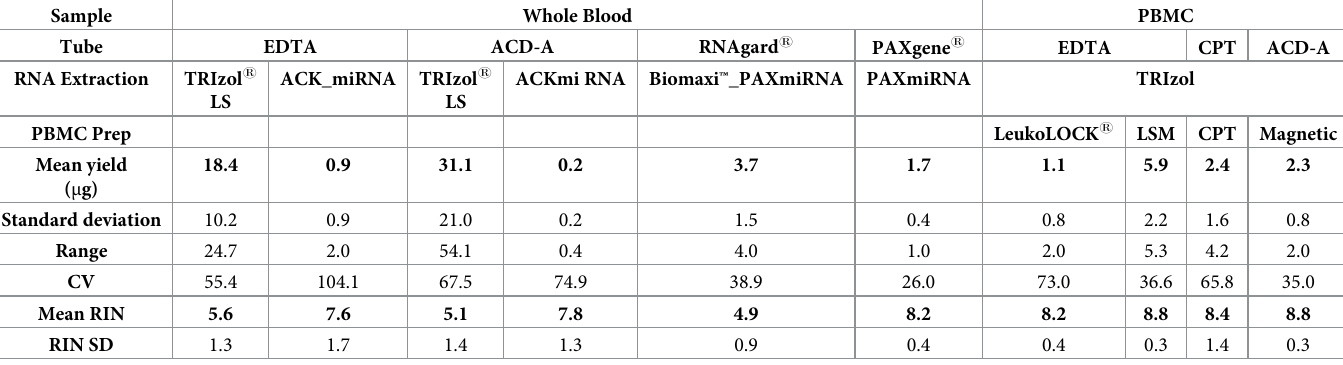
Table 1. General statistics for RNA concentration (in micrograms) and RNA integrity number (RIN) data per mL of blood. The sample collection tube followed by RNA extraction procedure is listed in the rows. The PBMC separation procedure is also referred as PBMC prep. CV refers to coefficient of variation and SD refers to stan- dard deviation and μ g refers to microgram.